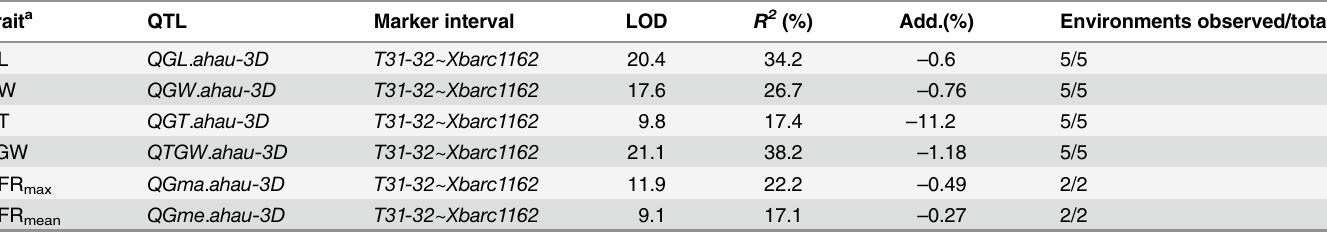
Table 3. Summary of QTLs for grain traits in the RILs from the Jing 411/Hongmangchun 21 cross, across different environments. Trait a